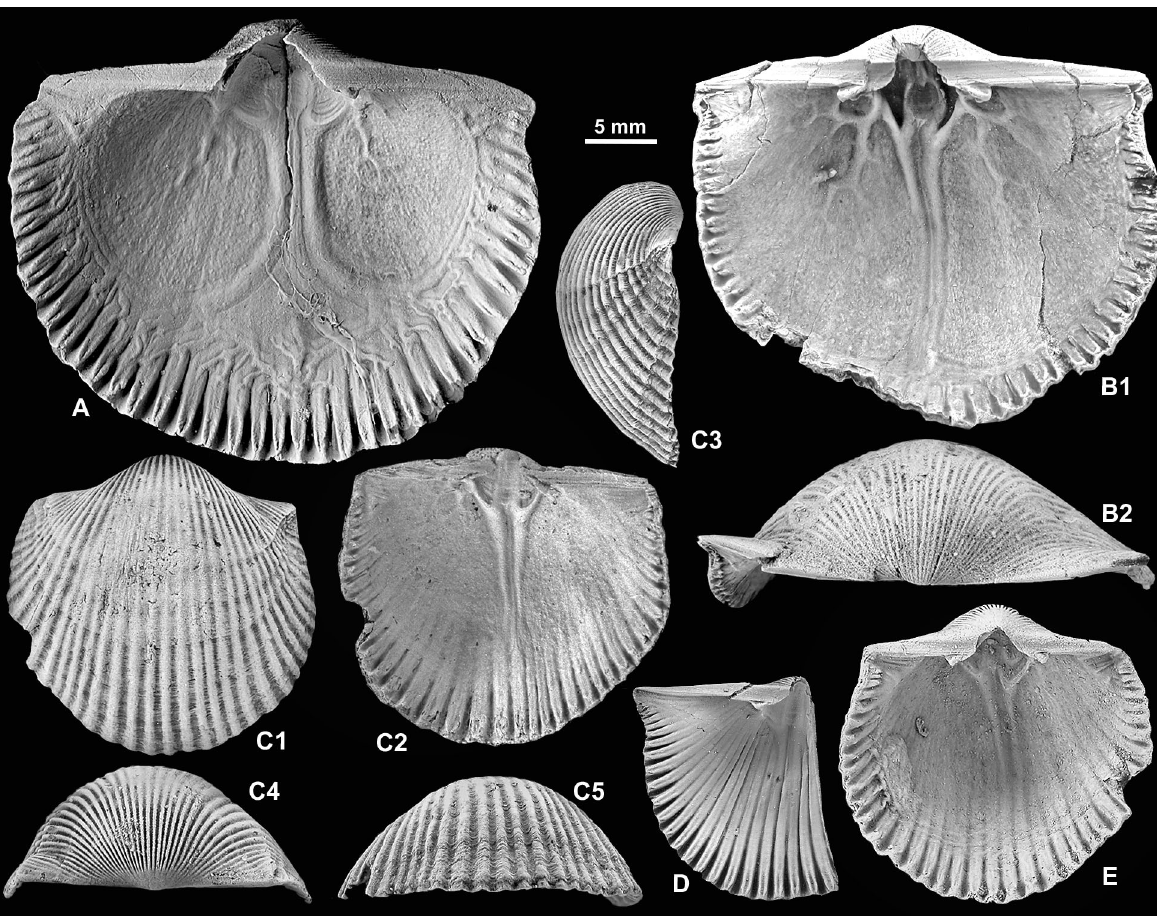
Fig. 2. A , Cyrtonotella kuckersiana kuckersiana (Wysogórski, 1900), ventral interior, TUG 1954-16 (Br 074), Kohtla, northeastern Estonia, Kukruse Regional Stage (RS). B1 , B2 , Cyrtonotella laine (Öpik 1930a), ventral valve GIT 400-19, interior and posterior views. Kohtla-Nõmme, northeastern Estonia, Kukruse RS. C1 – C5 , Cyrtonotella laine (Öpik 1930a), ventral valve GIT 400-50, exterior, interior, lateral, posterior and anterior views, GIT 400-50, Kohtla, northeastern Estonia, Kukruse RS. D , Cyrtonotella kuckersiana cf. kuckersiana (Wysogórski, 1900), interior of ventral valve GIT 400-7, Küttejõu quarry, northeastern Estonia, Kukruse RS. E , Cyrtonotella laine (Öpik 1930a), ventral valve GIT 400-11, ventral interior, Kohtla, northeastern Estonia, Kukruse RS. The scale is the same for all